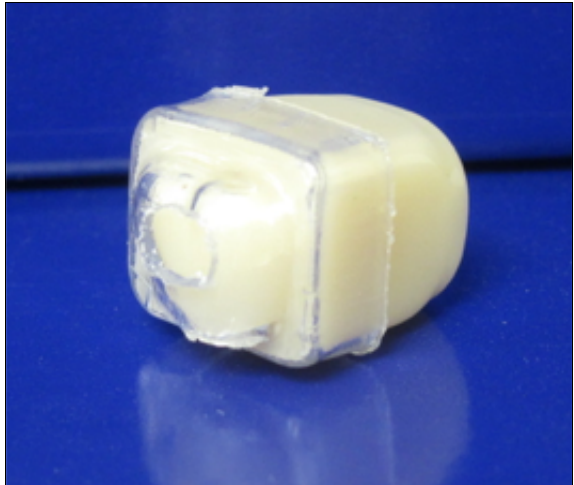
Figure 2. Essix bonding